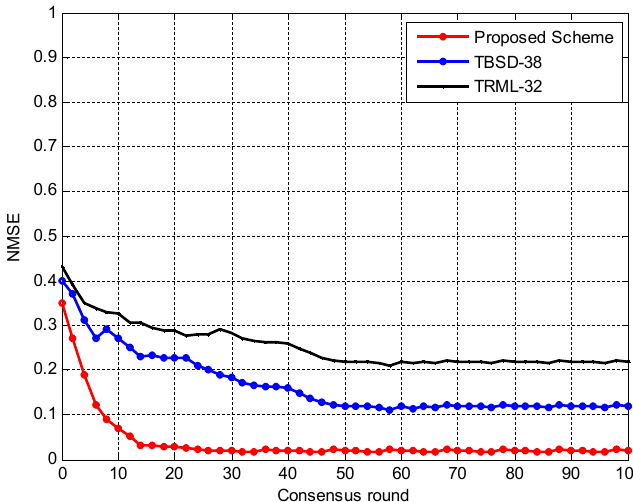
Figure 9. The NMSE results of the three trust algorithms.